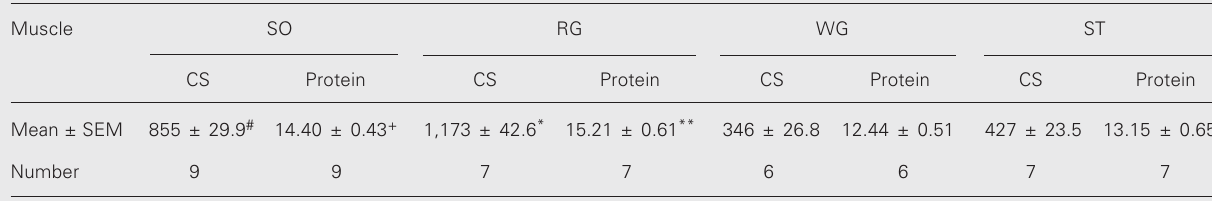
Citrate synthase (nmol min -1 mg tissue -1 ) was determined in the 20,000 g supernatant of a 30-mg homogenate. Protein content (mg/ml) was determined in the 20,000 g supernatant by the method of Bradford. CS = citrate synthase; RG = red gastrocnemius; SO = soleus; ST = semitendinosus; WG = white gastrocnemius. *P < 0.001 compared to all muscles; # P < 0.001 compared to WG and ST (one-way ANOVA). **P < 0.01 compared to WG and ST; + P = 0.01 compared to WG (one-way